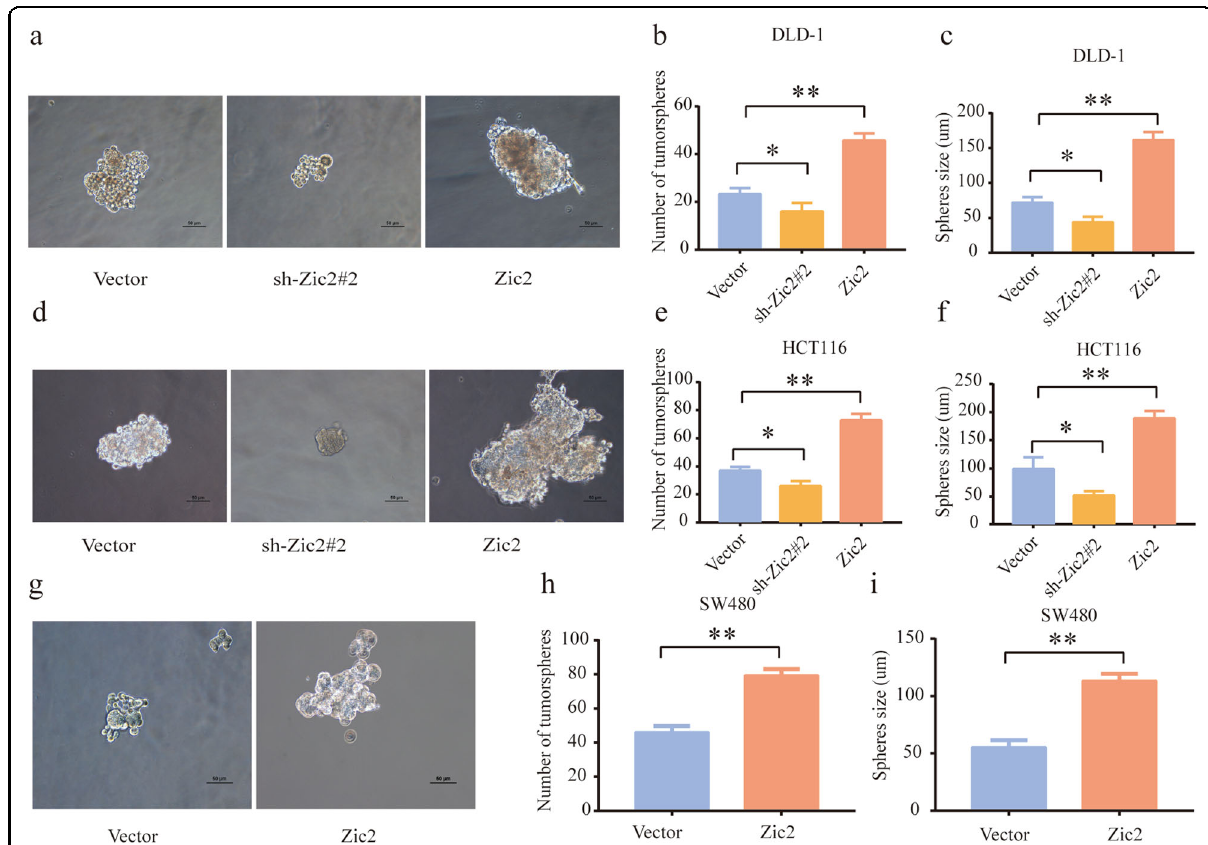
Fig. 3 Zic2 expression positively correlates with colon CSCs property. a , d , g Representative images of tumorsphere from cell lines with different expression levels of Zic2 . b , e , h Sphere number in cell lines with different expression levels of Zic2. c , f , i Sphere size in cell lines with different expression levels of